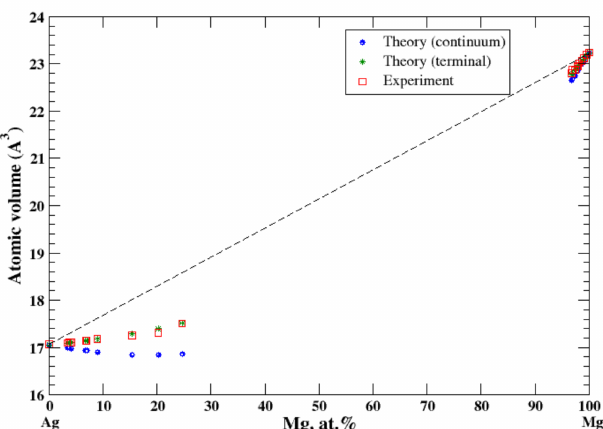
Figure 16. Atomic volume vs. concentration for Ag-Mg alloy system. The experimental data are from Ref. [16] (p. 292 and p. 729).